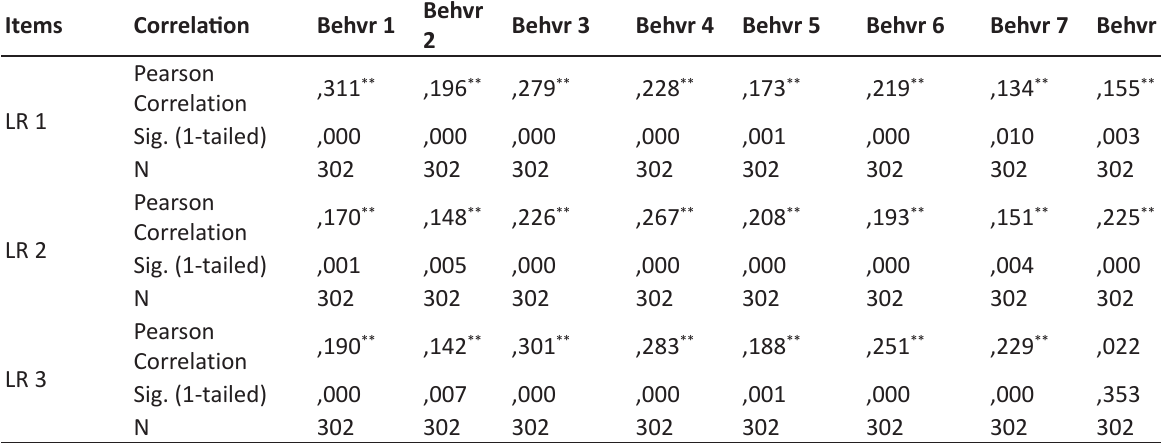
Table 4. Correlations between the CT behavior and the life repercussions Items